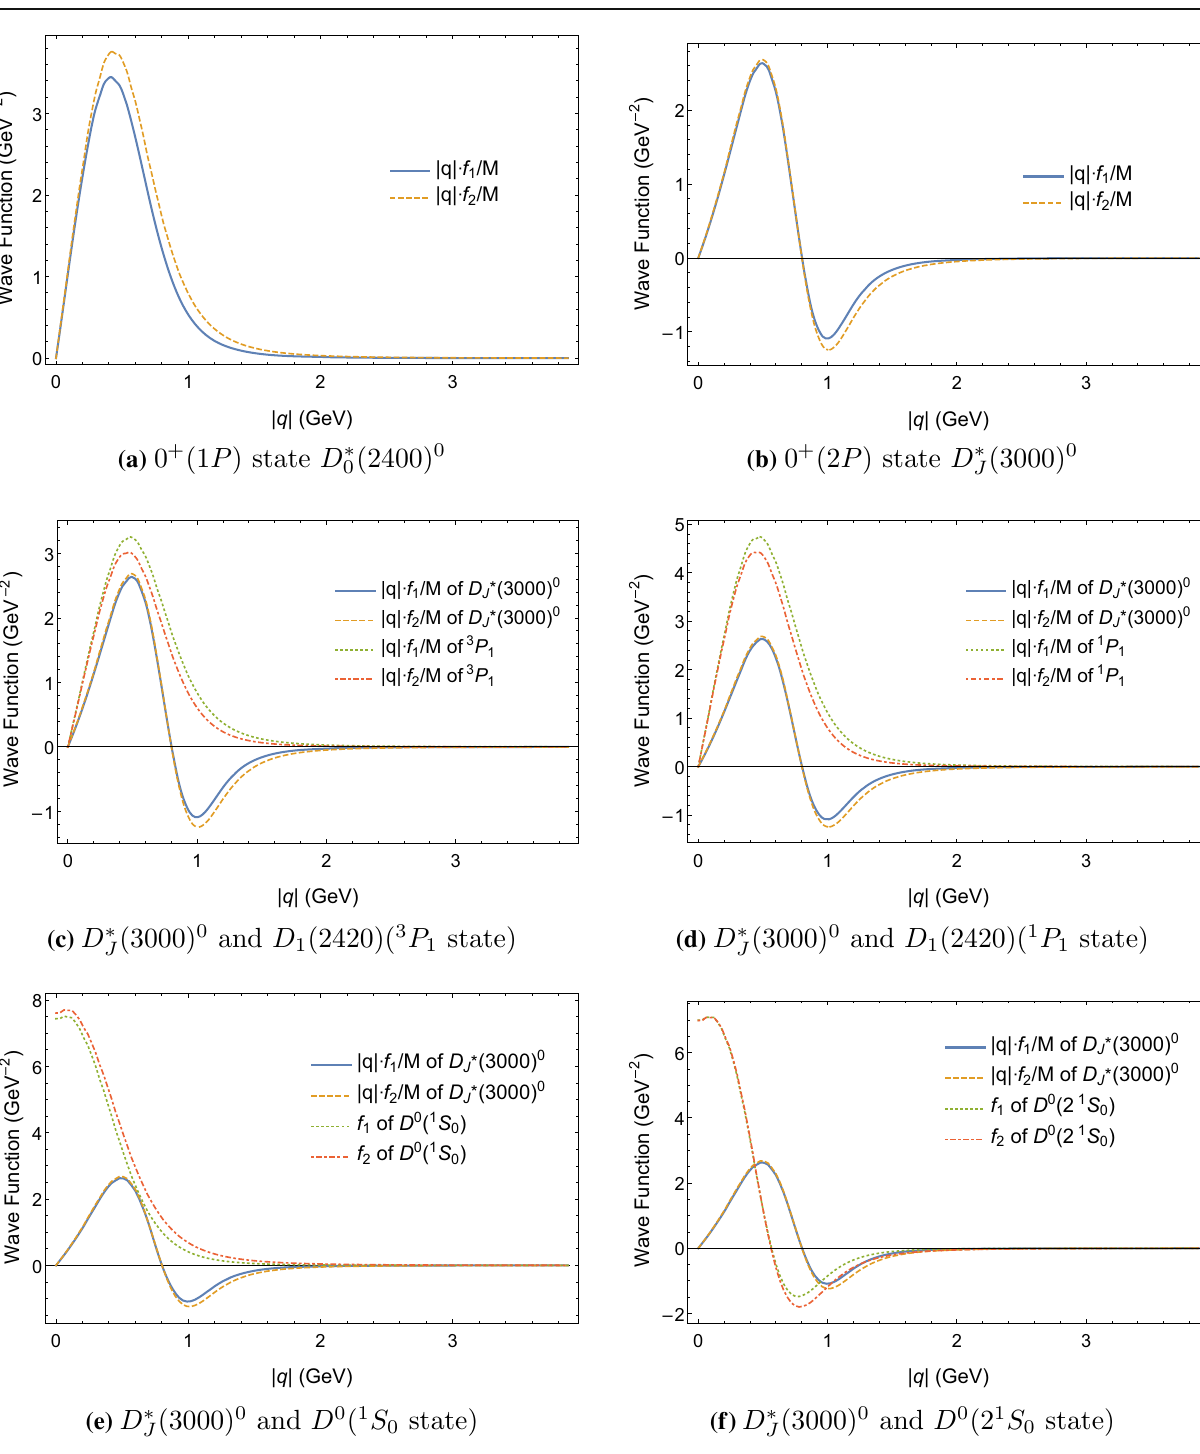
totalwidthoftheneutralonerangesfrom135.6to126.3MeV, while the charged one’s result changes from 136.8 to